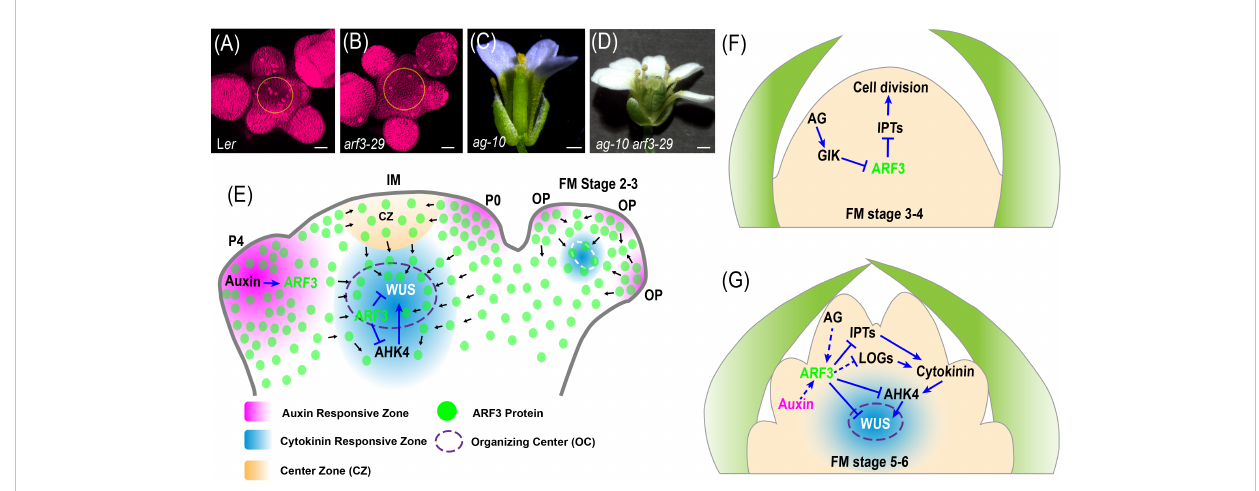
FIGURE 2 Models of SAM and FM activity control by ARF3. (A, B) , Representative images of SAM for the indicated genotypes (from Zhang et al., 2022, provided by Dr. Ke Zhang). (C, D) , Representative images of fl ower for the indicated genotypes. (E) , In the IM, auxin promotes ARF3, which migrates from the peripheral zone (PZ) to the organizing center (OC) where it directly represses AHK4 and WUS expression to control meristem activity in a non-cell- autonomous manner. Figures adapted from (Zhang et al., 2022). P0 and P4, primordia of fl ower buds at different developmental stages; OP, fl ower organ primordia. (F) , At stages 3-4 of fl oral development, AG indirectly represses ARF3 expression through GIK, and consequently enhancing IPTs to promote cell division and maintain the meristem cell population, thereby favoring fl oral meristem (FM) maintenance. Figures adapted from (Zhang et al., 2018b) (G) , At stages 5-6 of fl oral development, auxin and AG promote ARF3 expression, which in turn directly represses IPTs , and AHK4 and indirectly represses LOG genes expression. The resulting inhibition of cytokinin activity is required for proper temporal termination of WUS expression during FM determinacy. Figures adapted from (Zhang et al., 2018b). Blue solid and dashed arrows indicate direct and indirect positive regulation, respectively. Blue solid and dashed block lines indicate direct and indirect negative regulation, respectively. Black arrows indicate the direction of protein